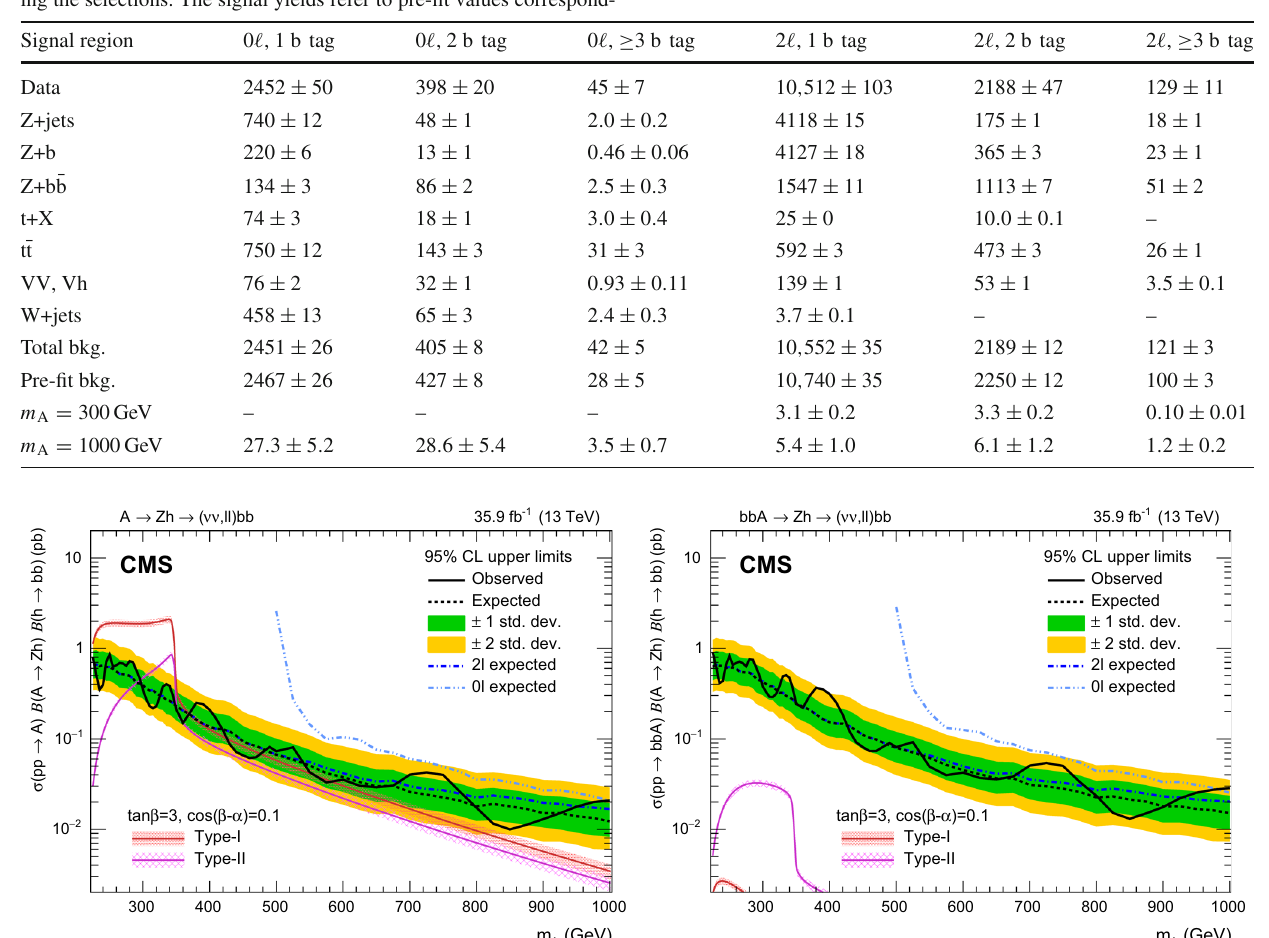
ing to a cross section multiplied by B ( A → Zh ) B ( h → b ¯ b ) of 0 . 1 pb (gluon–gluon fusion for m A = 300GeV, and in association with b quarks for m A = 1000GeV)